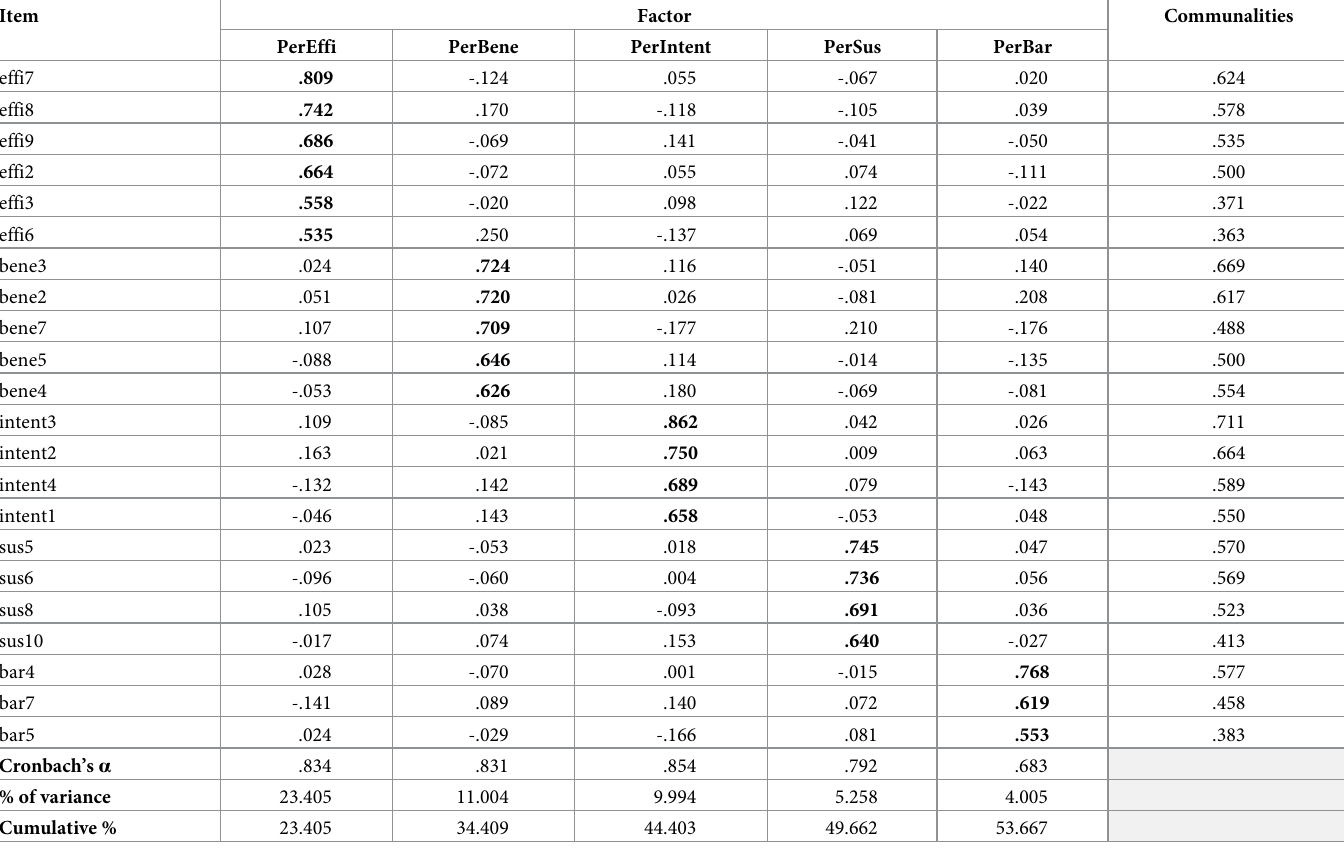
Table 1. Factor loading results and internal reliability of the factors of the final EFA model (22-item questionnaire). Item